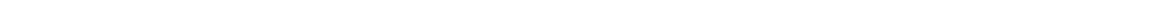
Fig. 1 Rbfox1 levels depend on miR-980 and stress. a Schematics of ovaries and a single ovariole (lower panel), where the germline (blue) is surrounded by the somatic follicular epithelium cells, in which at st.7, Notch signaling-dependent mitotic-to-endocycle and at st.10b, endocycle-to-ampli fi cation transitions occur. These phases are distinguished by Cut (red), expression of which is repressed by activated Notch signaling. Upon stress, egg production is sharply terminated at the nutritional stress checkpoint, resulting in small ovaries. Images of sated and 10-day protein-starved Control and miR-980 ovaries. Starvation response is not as robust in miR-980 mutants, their ovaries are larger and contain later stage egg chambers. b miR-980 overexpression signi fi cantly reduces expression of luciferase reporters (P1 and P2), containing parts of the extended Rbfox1 3 ′ UTR with different miR-980 binding sites. c miR-980 ovaries have signi fi cantly increased Rbfox1 mRNA levels. d Nutritional stress (2-day) in fl uences miR-980 and Rbfox1 expression in ovaries: miR-980 is signi fi cantly downregulated, while Rbfox1 is elevated. e Rbfox1 levels in wild type ( WT ), miR-980 , and Rbfox1-overexpressing ( hsFlp; act > CD2 > Gal4 UAS-GFP/UAS-Rbfox1-RE ) ovaries from sated and protein-deprived animals detected by western blotting. Colored arrows point to Rbfox1 isoforms that were used for Rbfox1 expression quanti fi cation shown in the bar graph. f Rbfox1 expression pattern is temporally and spatially dynamic. At mitotic stages (st.3 – 6), Rbfox1 is nuclear; at early endocycling (st.6 – 8), its levels are strongly decreased; at late endocycling (st.9 – 10a), nuclear Rbfox1 reappears. At ampli fi cation stages (st.11 – 14), Rbfox1 nuclear expression is strongly reduced, but the moderate cytosolic remains. g In miR-980 Ex1-2 , Rbfox1 is elevated in comparison to Control egg chambers of the corresponding stages. h Assembly of Control and miR-980 ovarioles under normal and starvation stress conditions. Delayed termination of egg production in miR-980 mutants is rescued by Rbfox1 downregulation. i Quanti fi cation of ovarioles with no response to starvation. Introduction of one copy of Rbfox1 mutation to the miR-980 loss-of-function background rescues the phenotype. DAPI (green), Cut (blue), Rbfox1 (red, rabbit anti-Rbfox1). f , g maximum intensity projections of multiple Z-sections. Scale bars 5 µ m. AVE ± SD are reported from triplicates, two- tailed Student ’ s t-test was applied for statistics in b – d , and Chi-square test in i . See Supplementary Tables 1 – 3. ** p ≤ 0.01 , *** p ≤